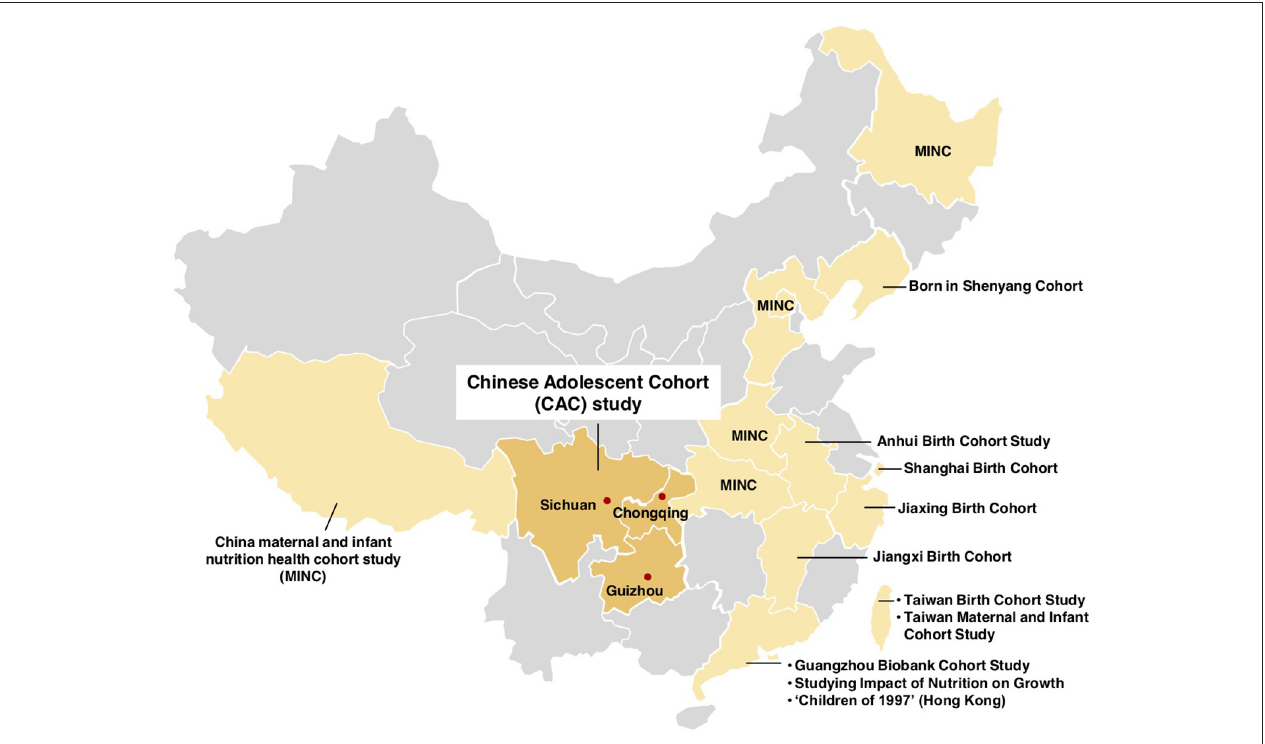
FIGURE 1 | Location of the Chinese Adolescent Cohort study and other child cohorts in China.